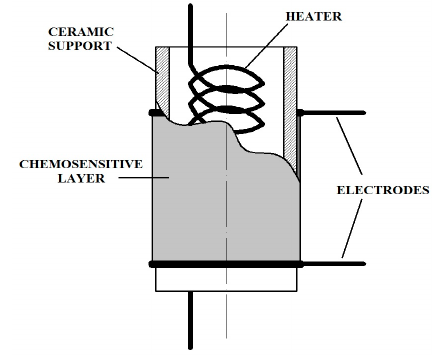
Figure 3. Scheme of MOS-type sensor.